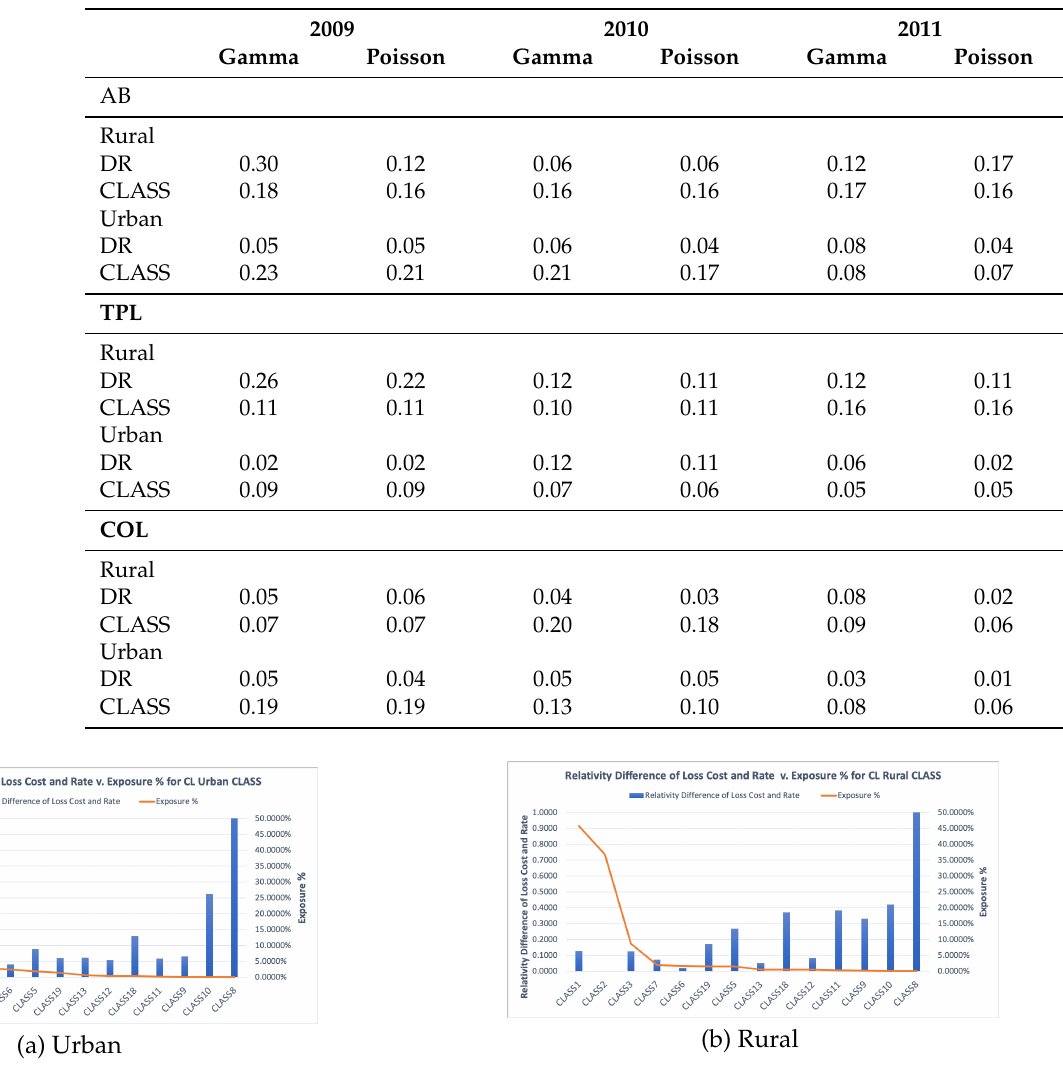
Figure 3. The relativity differences between loss costs and premiums for different levels of CLASS, and the percentage of risk exposures of the corresponding levels of CLASS, for COL